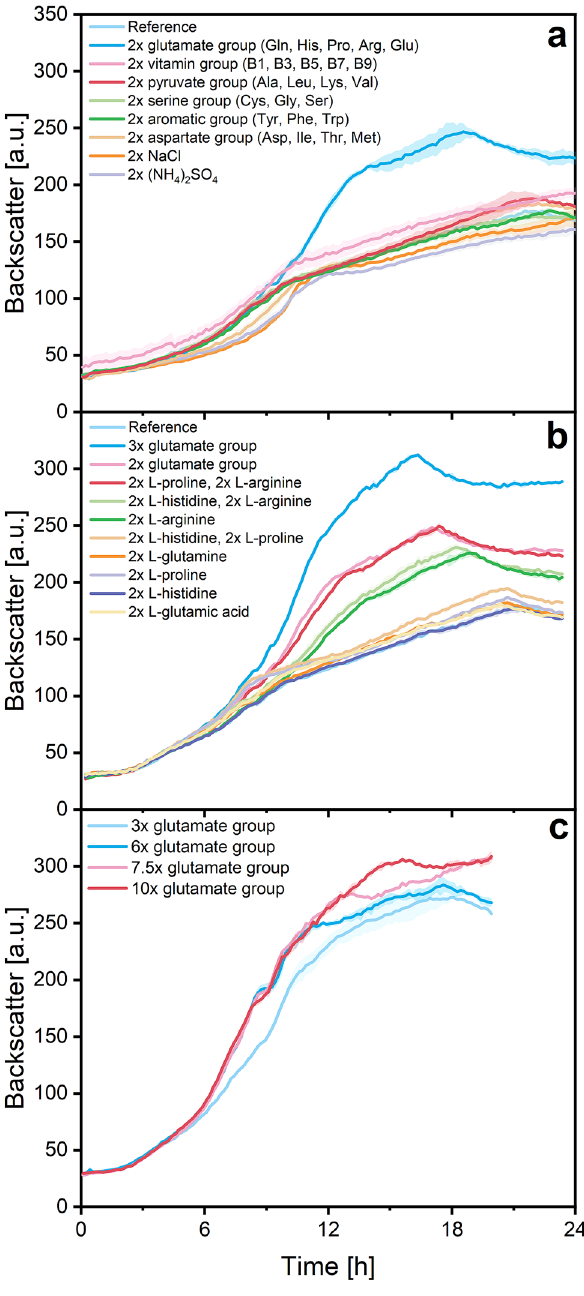
Figure 2. Backscatter data from three different microplate cultivation experiments of S. pasteurii in supplemented chemically defined media to determine substrate growth limitations. Illustrated are backscatter data from different growth curves after adding grouped or single components. The reference data corresponds to cultivation in chemically defined medium (Table 1). The cultivation experiments a , b and c were stopped during stationary phase resulting in different total cultivation durations. Average pH of all cultures: 9.29 ± 0.12. Culture conditions: 48-well Flower Well Plate, filling volume 800 µ L, shaking frequency 1200 rpm, shaking diameter 3 ◦ mm and temperature 30 C. Here, arithmetic mean values derived from biological replicates (N = 3) are shown. The error bands depict the standard